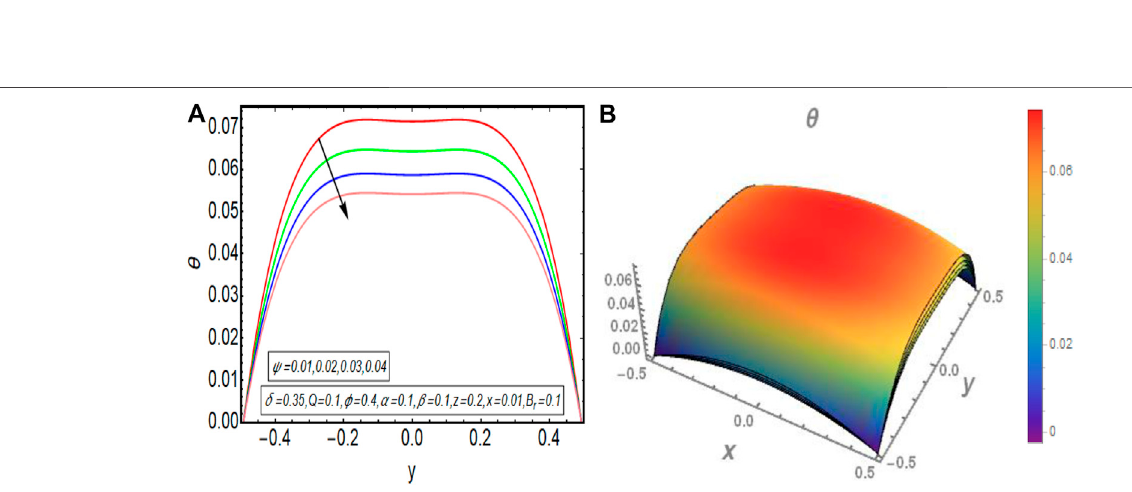
FIGURE 7 | (A) 2D-Temperature plot for volumefractionof nanofluid . (B) 3D-Temperature plot for volumefractionof nanofluid .